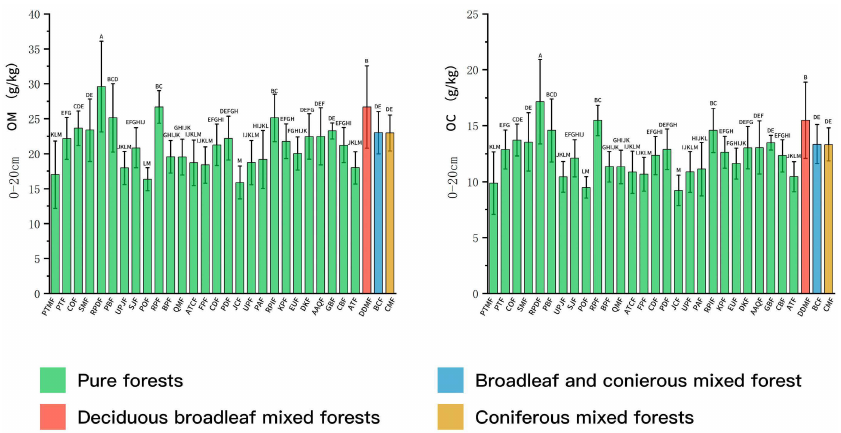
Figure 4. Multiple comparative analyses of soil organic carbon and organic matter in different urban forest communities. OC: organic carbon; OM: organic matter Note: Different lowercase letters indicate significant differences in soil organic matter and organic carbon values between different community types ( p < 0.05). Abbreviations of community names refer to Table